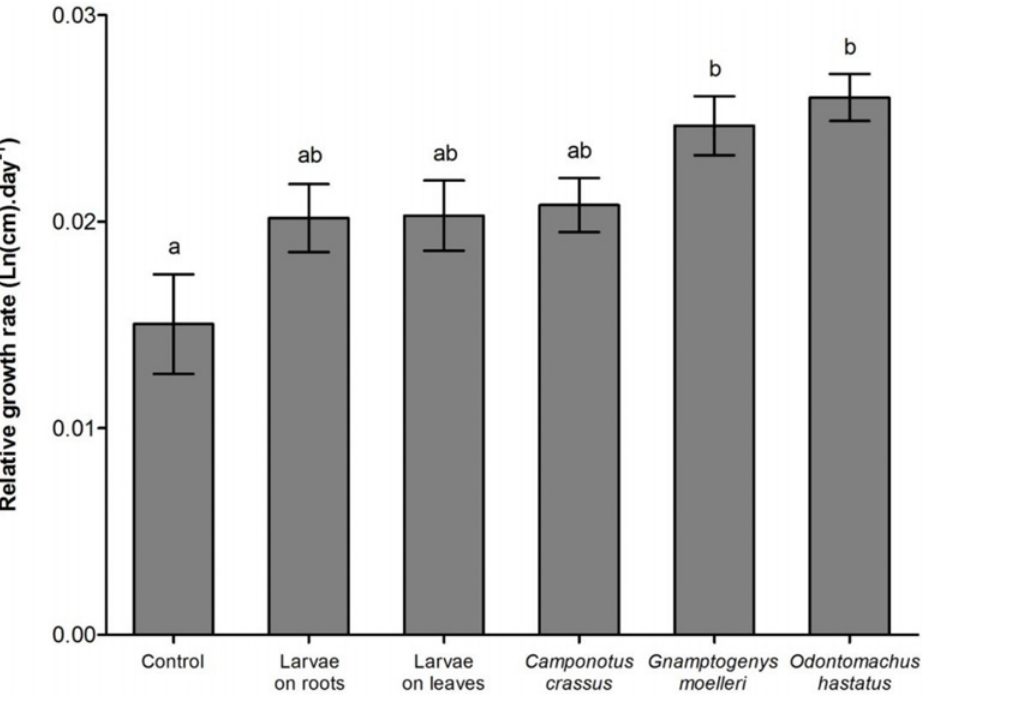
Fig 3. Relative growth rate of bromeliads. Relative growth rate of the Quesnelia arvensis leaves from different treatments (control; Tenebrio larvae among roots; Tenebrio on leaves; Camponotus crassus ants and Tenebrio ; Gnamptogenys moelleri and Tenebrio ; and Odontomachus hastatus and Tenebrio ). Bars indicate the standard error and letters indicate Tukey post-hoc test ( α < 0.05).